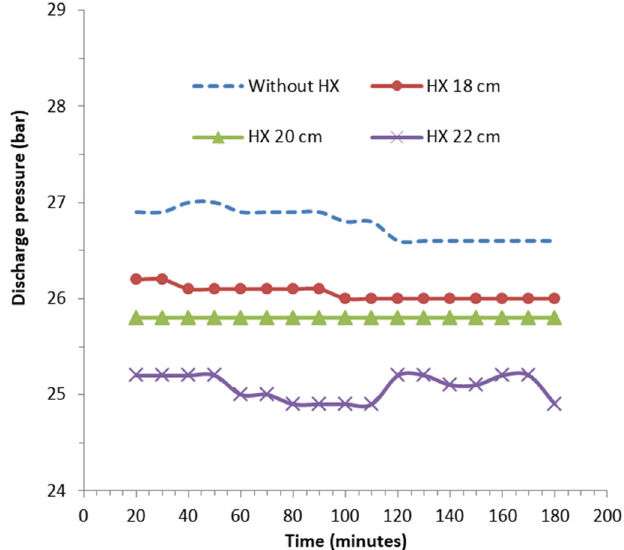
Figure 8. Discharge pressures of A/C using condensate as a subcooler for three different lengths of heat exchangers.